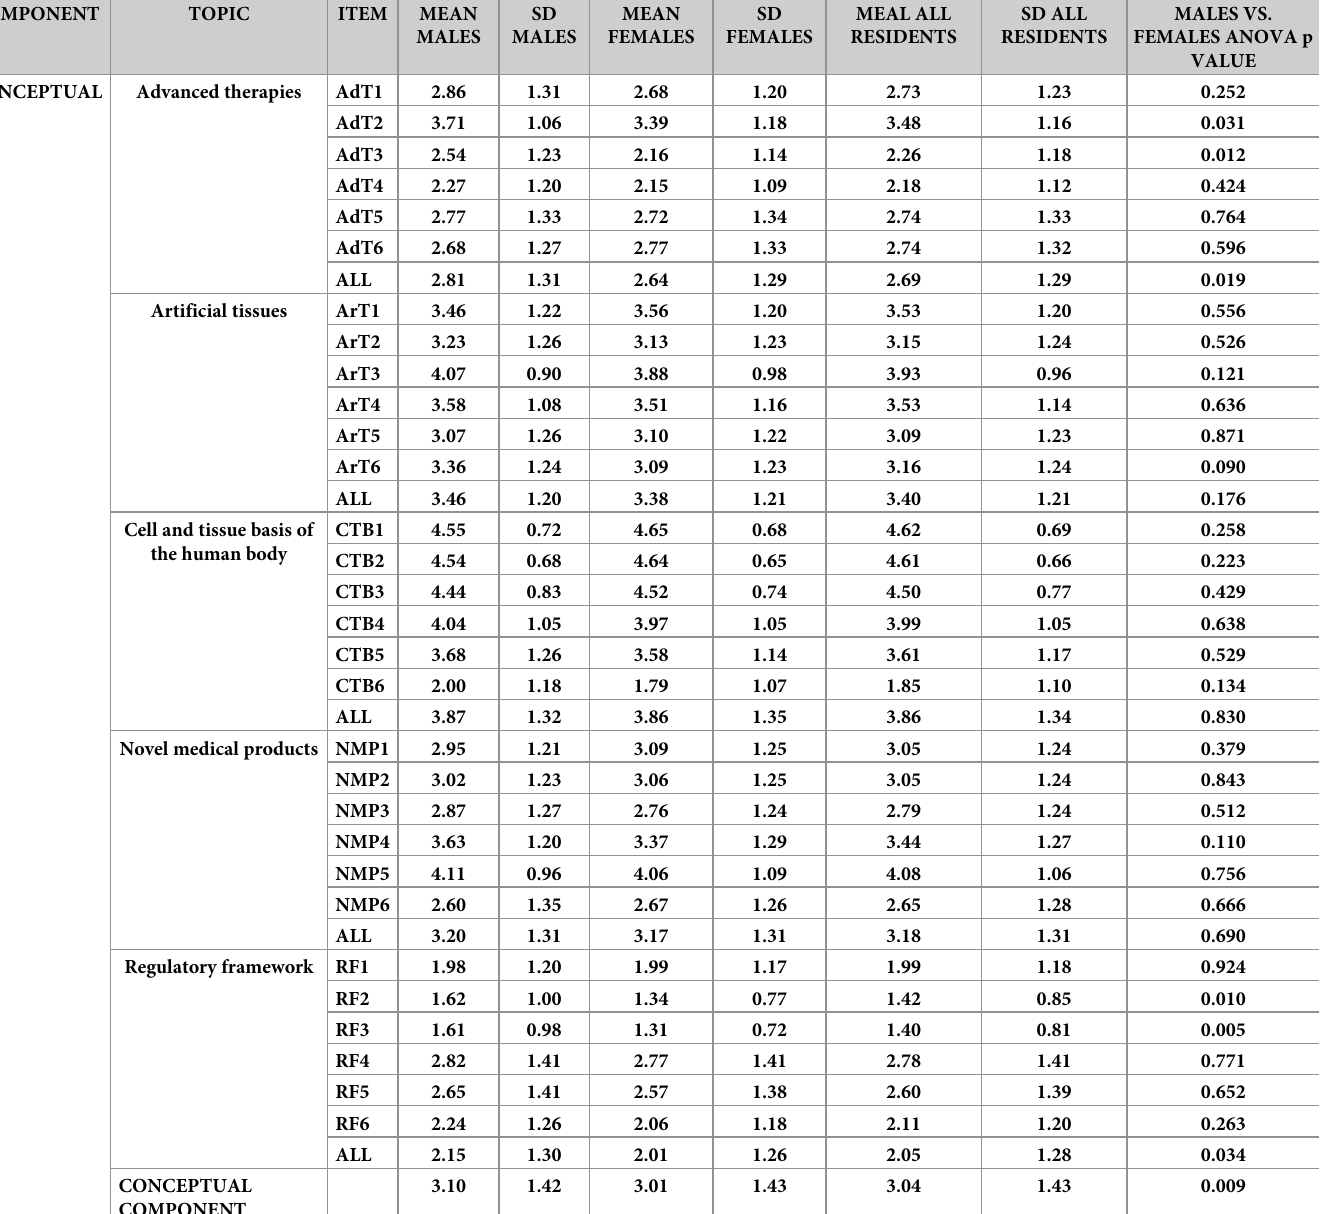
Table 2. Mean values and standard deviations (SD) for the conceptual component and for each topic and each item included in this component. In each case, results are shown for male and female residents separately and for all residents together. The last column shows the statistical p value for ANOVA comparisons between genders. COMPONENT TOPIC